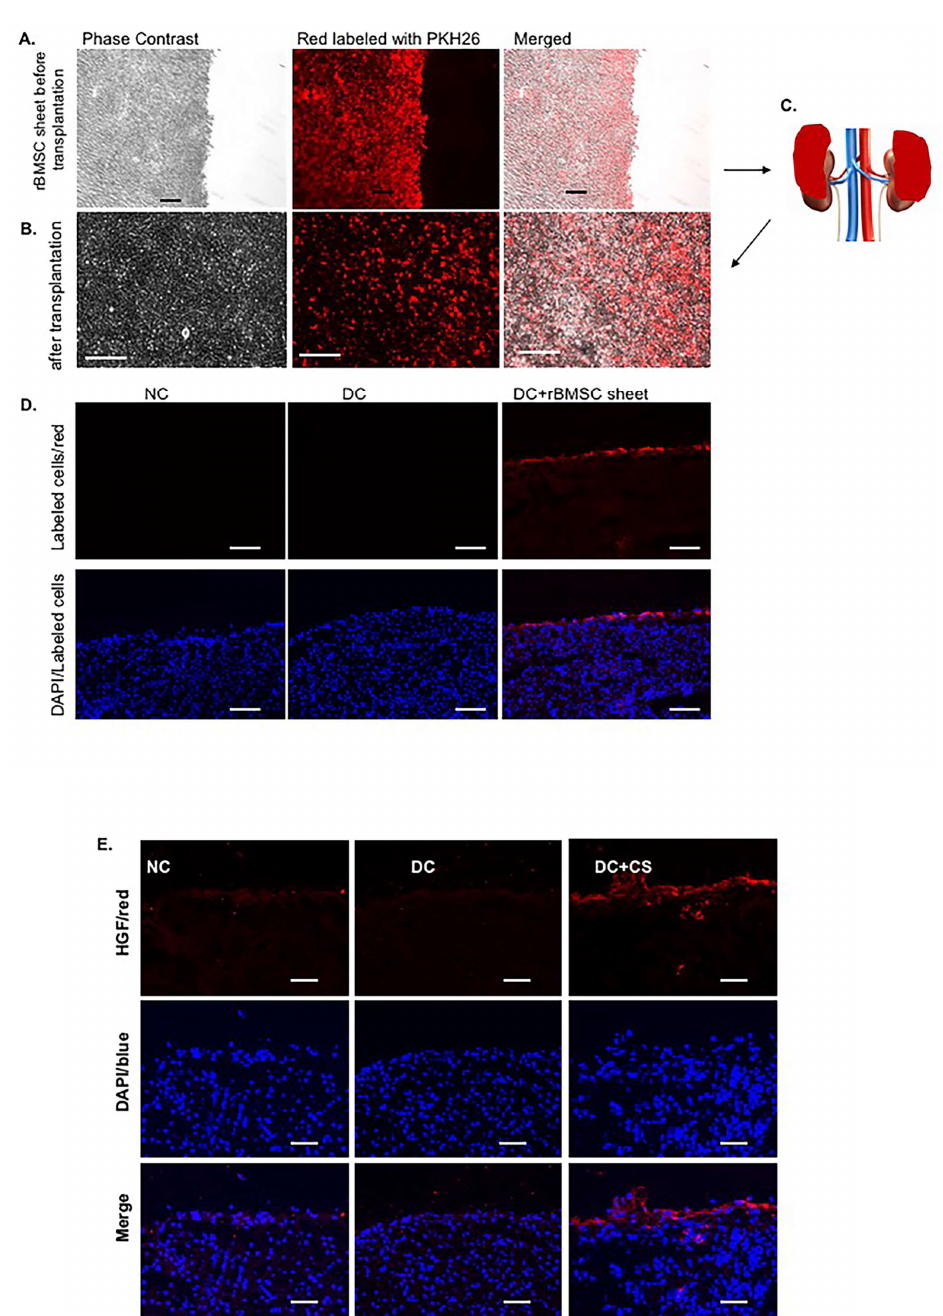
Figure 2. Verification of transplanted rBMSC sheets on the target site. ( A , B ) Representative photomi- crographs of rBMSC sheets labeled with PKH-26 dye (in red) before transplantation ( A ) and after transplantation ( B ). Scale bars represent 100 µ m. ( C ) Schematic representation of the transplantation sites of the rBMSC sheets in a rat with chronic glomerulonephritis. The renal capsule was removed from the anterior surface of the rat kidneys with tweezers, and one rBMSC sheet (in red) was placed on each site of the kidney where the renal capsule was removed. ( D ) Labeled rBMSC sheets with PKH-26 dye were observed directly on the surface of the frozen section of the kidneys at 4 weeks after transplantation. DAPI (in blue) stained nuclei served as cell counterstaining. Scale bars rep- resent 100 µ m. ( E ) Representative photomicrographs of immunofluorescent staining for HGF (in red) for rat kidneys from normal control (NC), untreated disease control (DC), and diseased rats that received rBMSC sheets (CS) transplantation (DC + CS). DAPI (in blue) stained nuclei served as cell counterstaining. Scale bars represent 50 µ